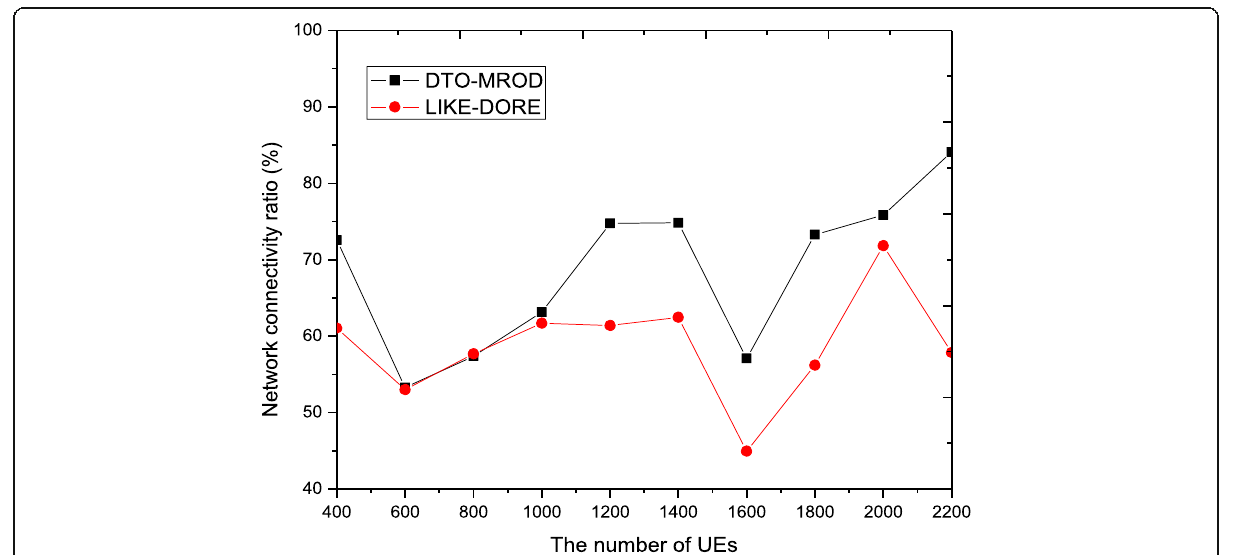
Fig. 6 Network connectivity ratio for the two schemes under the different numbers of UEs